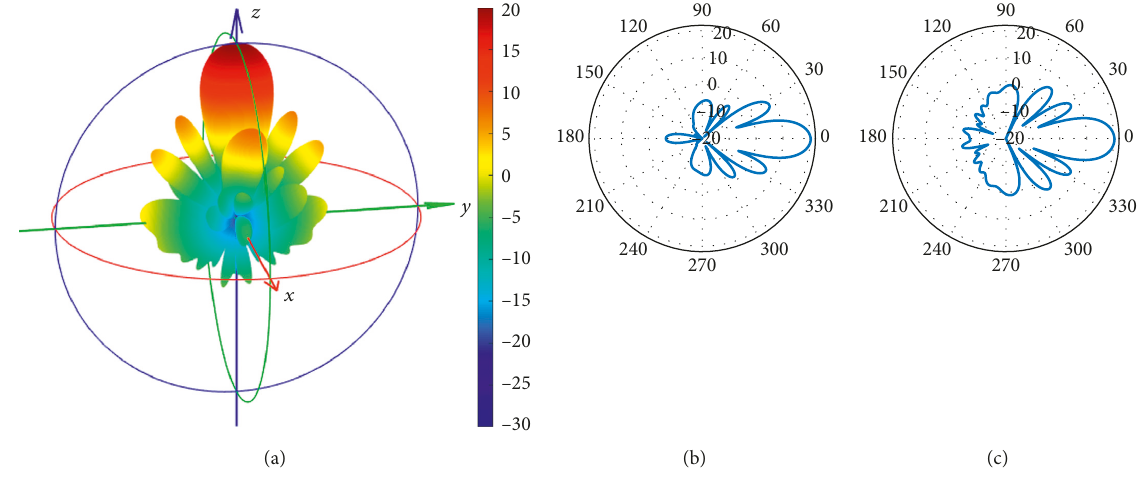
Figure 7: (a) 3D antenna pattern of the transceiver. (b) E plane. (c) H plane. Table 1: Locations and heights of the Tx and Rx. Parameters